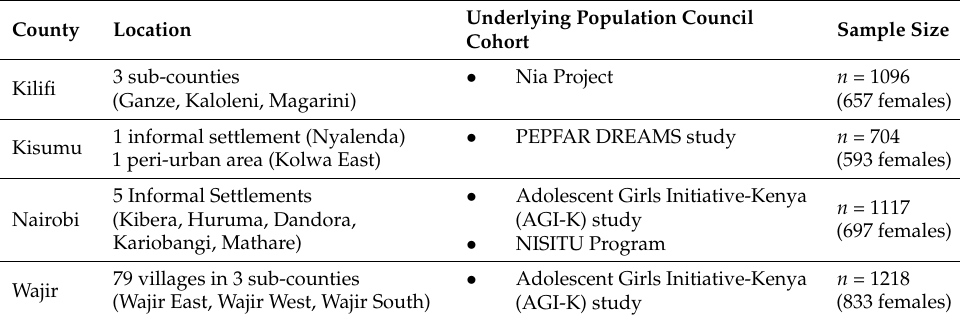
Table 1. Study population and sample